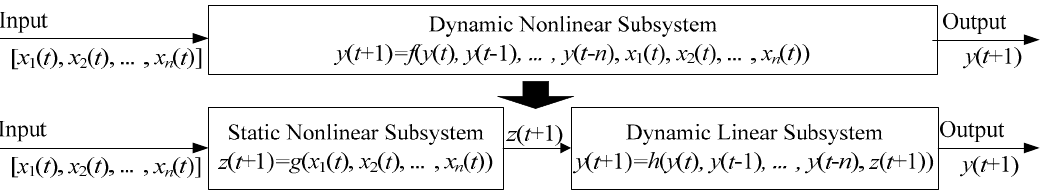
Figure 2. Implementation of combinational Hammerstein recurrent neural network (CHRNN) scheme, in which the predictions in Section A are generated using Strategy 0, whereas those in Sections B and C are generated using Strategy 1 and Strategy 2.